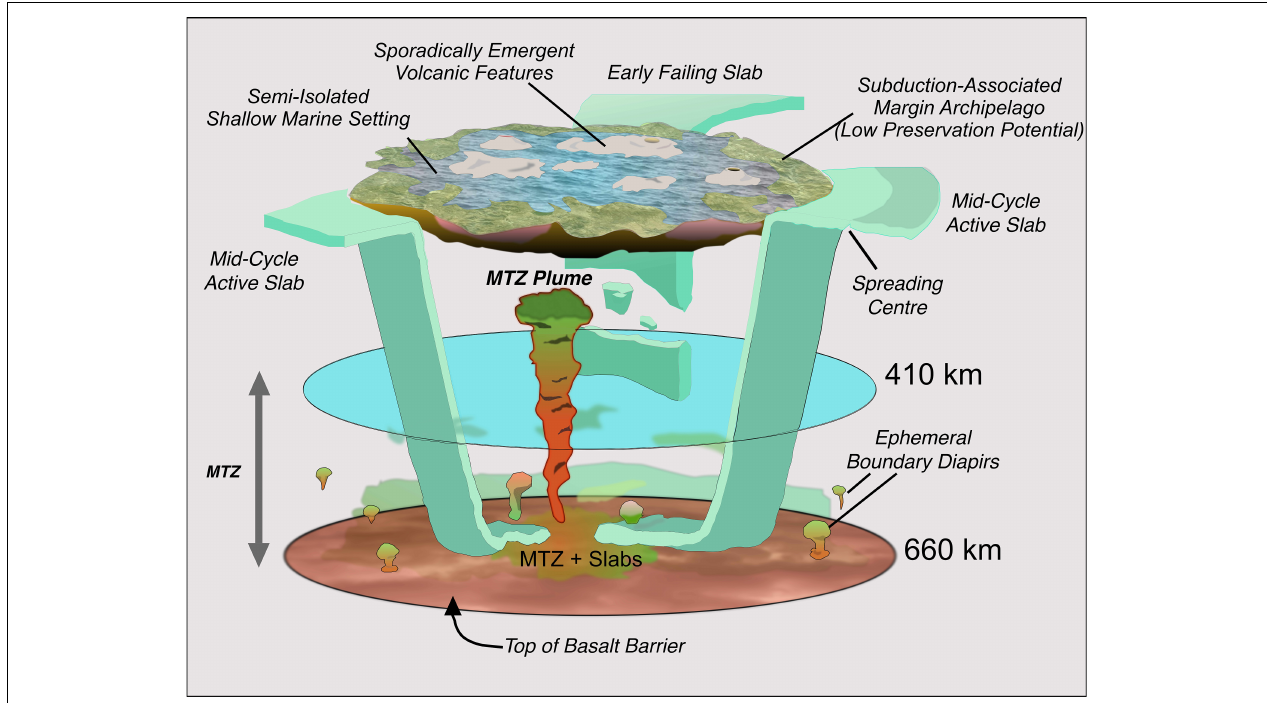
FIGURE 8 | An idealized version of the pre-plate tectonic subduction – plume circuit. Relatively small ( ∼ 1000 km-scale) proto-cratons, such as the early Pilbara, focus stress in the adjacent stagnant lid and initiate subduction. Local failure of subduction occurs but the event propagates around the craton. Subducted slab accumulates in a small volume of the MTZ (above “the basalt barrier”), which displaces a mixture of mainly MTZ peridotitic mantle and lesser amounts of entrained slab crust to form a mantle plume beneath the craton. Cratonic margins may have been reworked by succeeding circuit episodes and later events. Note that the Pilbara craton’s present margins are mainly obscured under cover or offshore (e.g., Hickman and Van Kranendonk, 2012). Small diapirs shown outside the region of subducting slabs reflect the fact that, as a significant thermal boundary, the basalt barrier could generate minor peridotitic upwellings anywhere. The spatial and temporal association of arc and plume volcanism in the geological record, however, demonstrates that big wedge settings facilitated the formation of plumes that were large enough to ascend through the mantle. The early cratons developed independently but global variations in mantle convection intensity may establish peak periods for circuit activity. By the late Archean, other subduction configurations were possible (e.g., inward-facing double subduction zones) and may have led to more sheet-like mantle